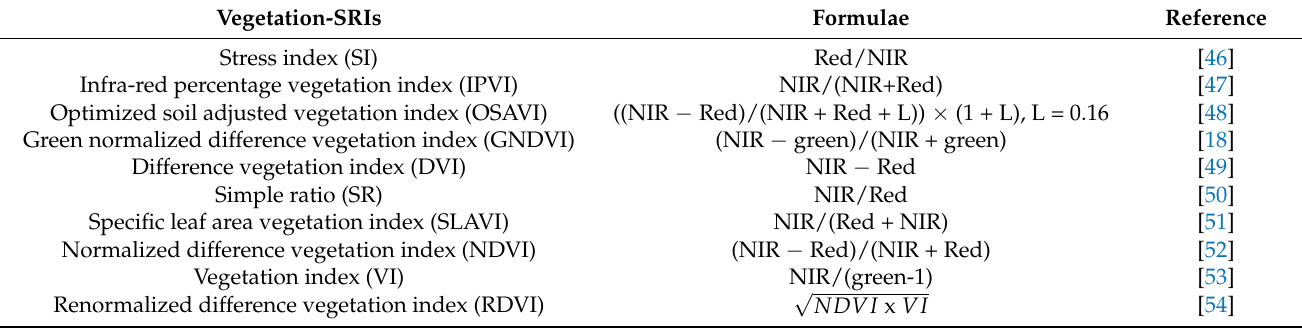
Table 2. Formulae of selected spectral reflectance indices (SRIs) and references collected from the literature. Vegetation-SRIs Formulae Reference Stress index (SI) Infra-red percentage vegetation index (IPVI) Optimized soil adjusted vegetation index (OSAVI) Green normalized difference vegetation index (GNDVI) Difference vegetation index (DVI) Specific leaf area vegetation index